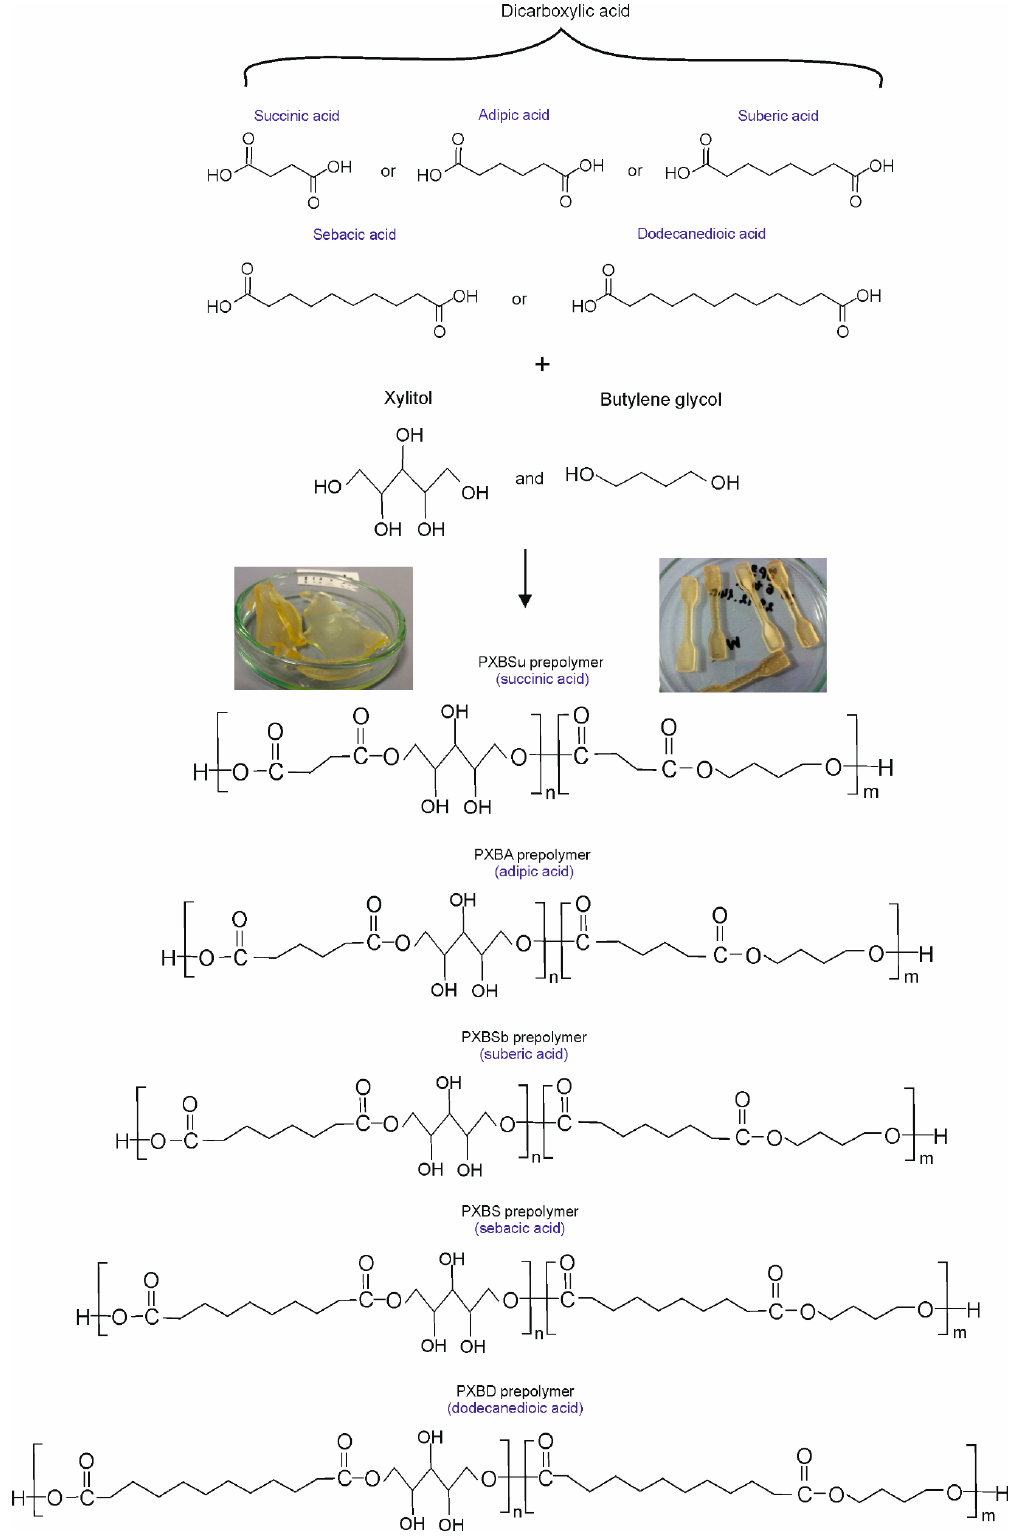
Figure 1. Scheme of poly(xylitol-dicarboxylate-co-butylene dicarboxylate) synthesis and